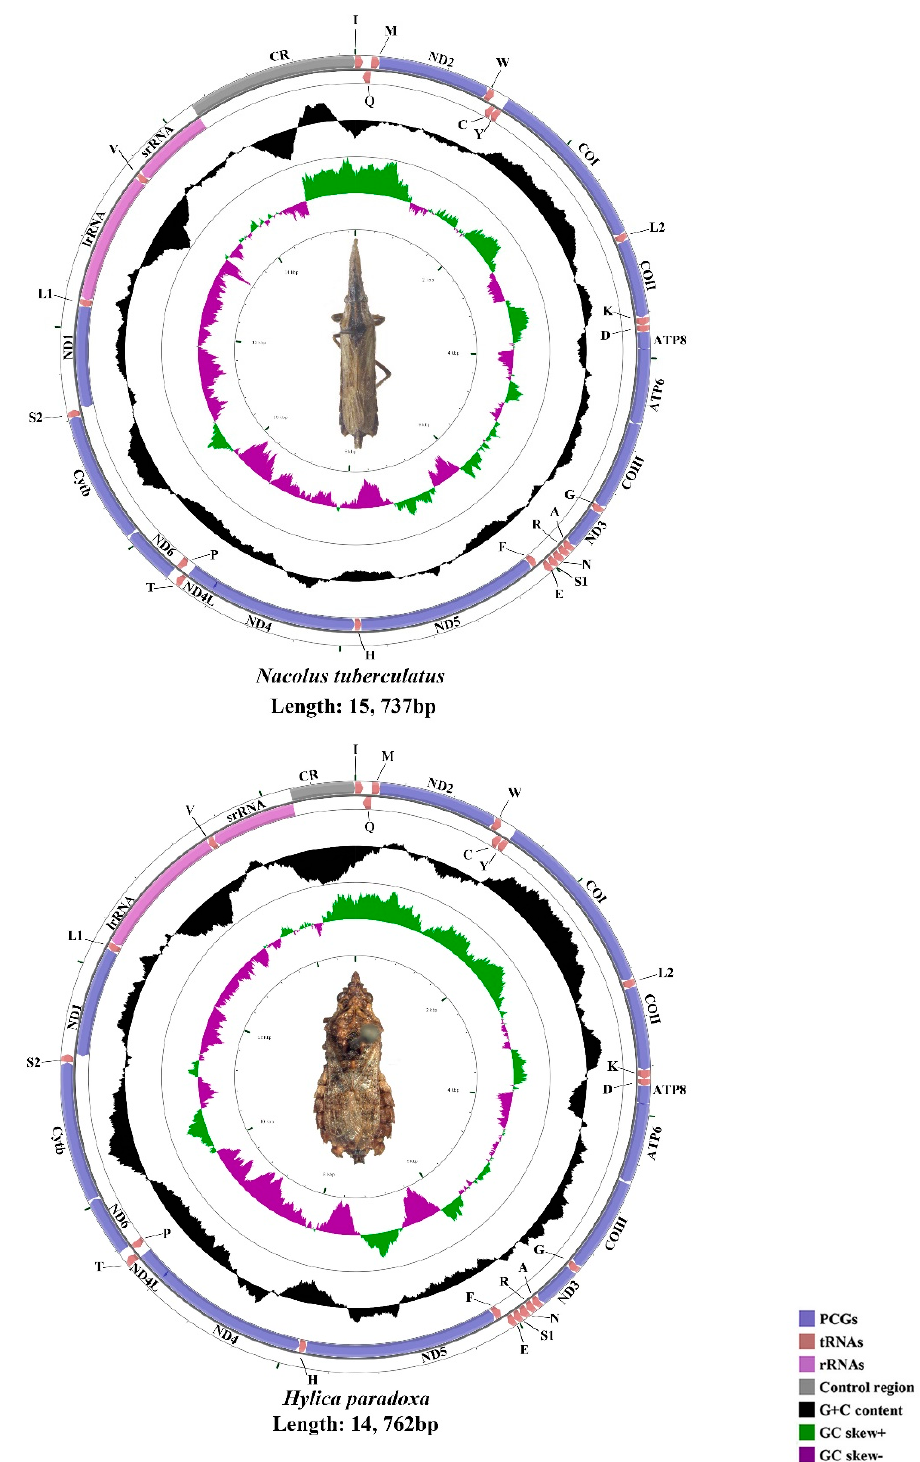
Figure 1. The circular 15.7 kb N. tuberculatus and 14.7 kb H. paradoxa mtgenomes .